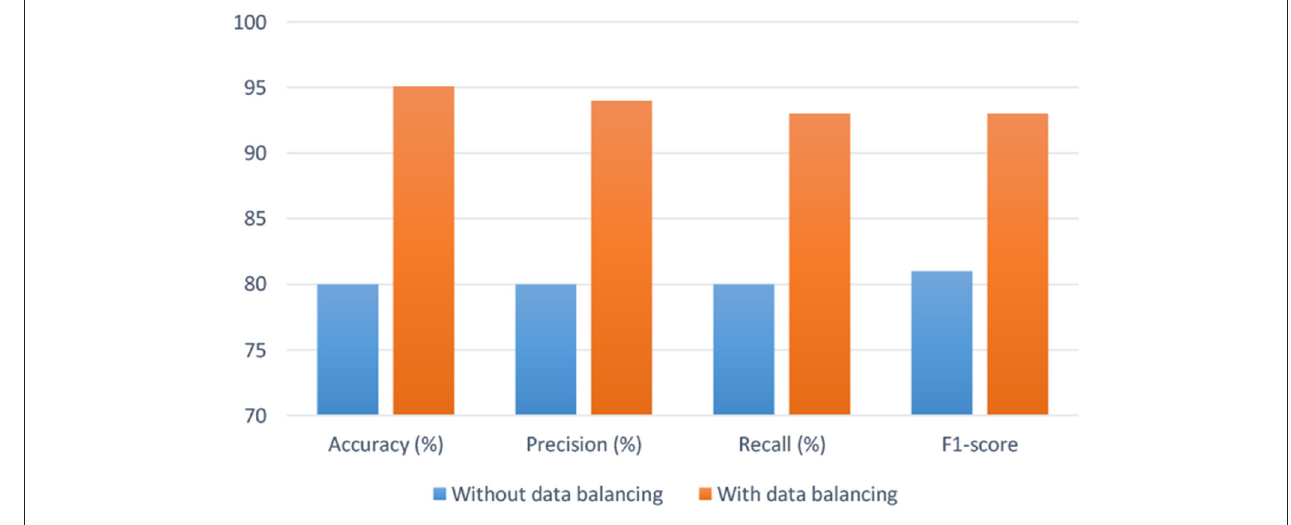
FIGURE 15 | Proposed model’s performance with and without balancing data.